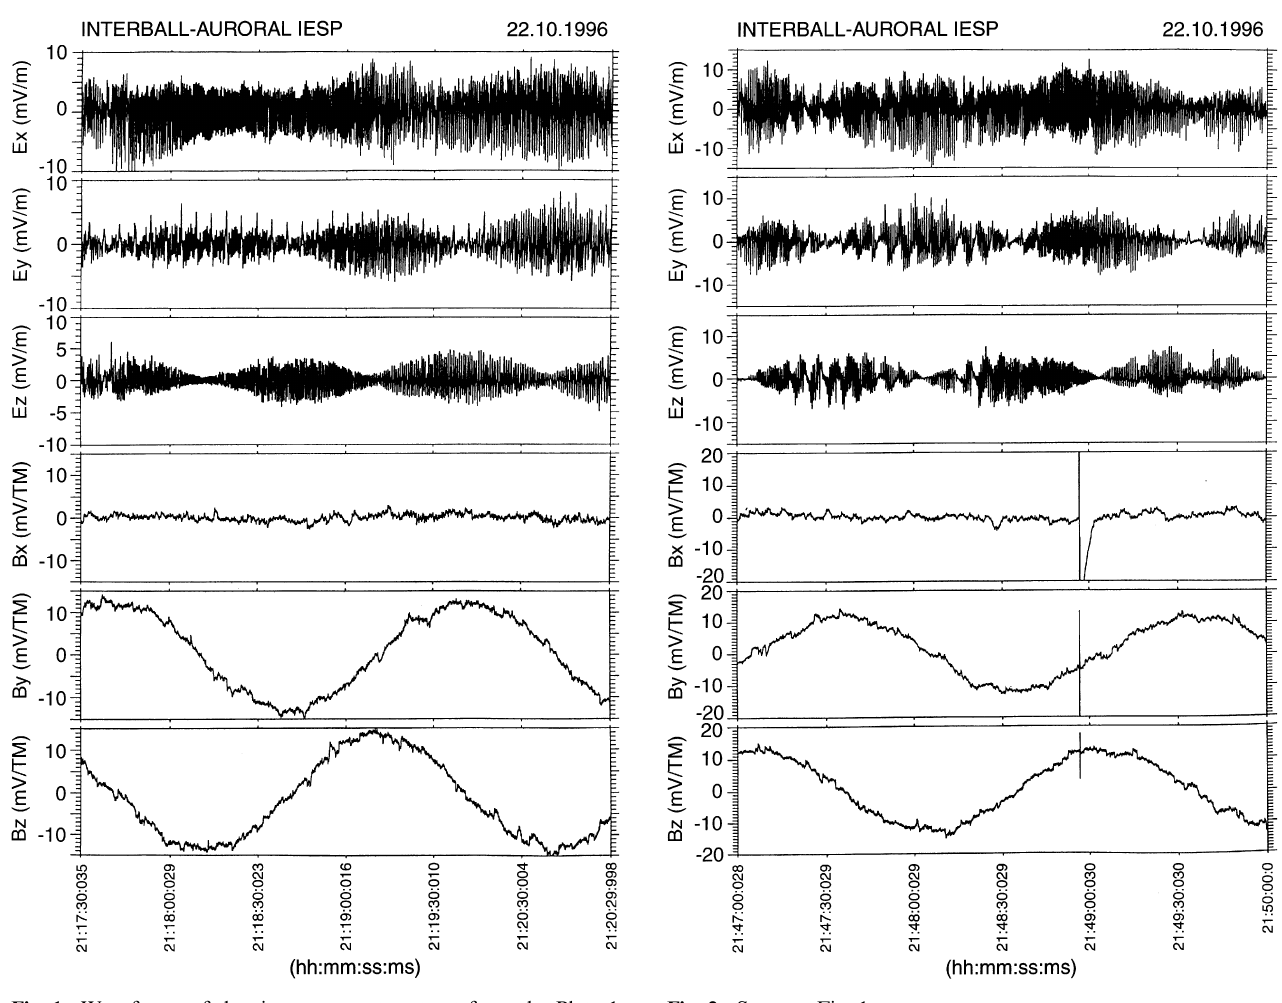
Fig. 1. Waveforms of the six components extract from the Plate 1 event; on the top the three electric and below the three magnetic. E and B are parallel to the spin axis. The spin period T X DC magnetic field B is large enough to induce a variation on the O magnetic components of the search coil in the spin plane. The electric components exhibit a very monochromatic wave, not seen on the magnetic ones. The amplitude modulation of E points out that this wave electric field is perpendicular to B